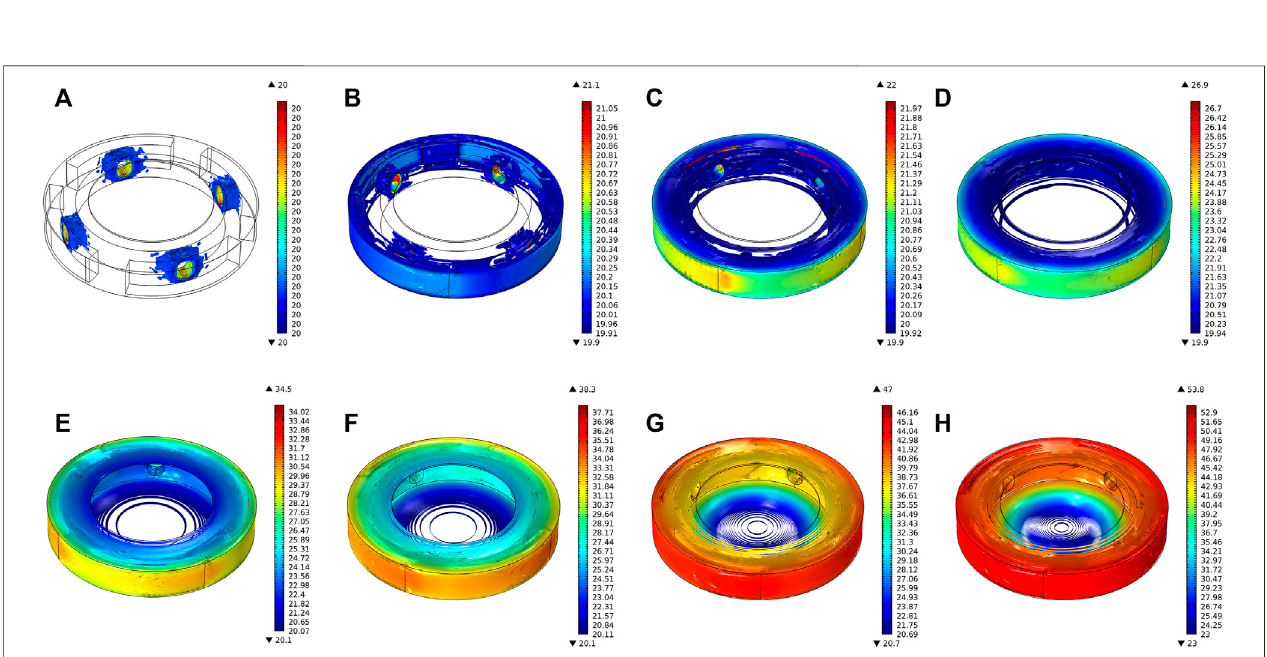
FIGURE9| TransienttemperaturedistributionofMRGtorsionalvibrationdamperforeachmomentofworkingcondition Ⅰ : (A) t=0 s, (B) t=0.4 s, (C) t=0.8 s, (D) t = 1.5 s, (E) t = 3 s, (F) t = 4 s, (G) t = 7 s, and (H) t = 10 s.